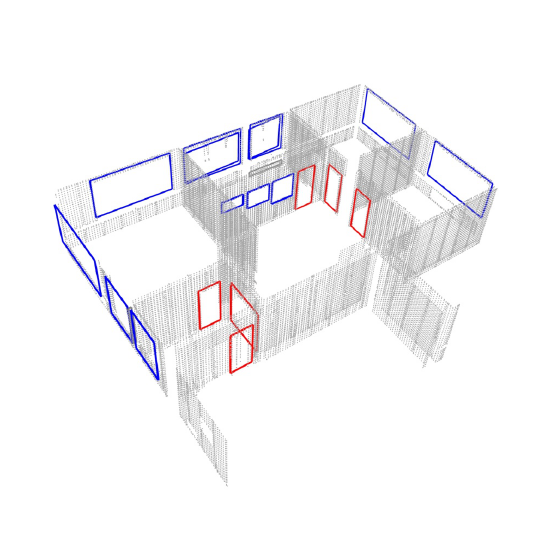
Figure 5. Wall segmentation (top view). Figure 6. Opening detection — doors (red), win- dows